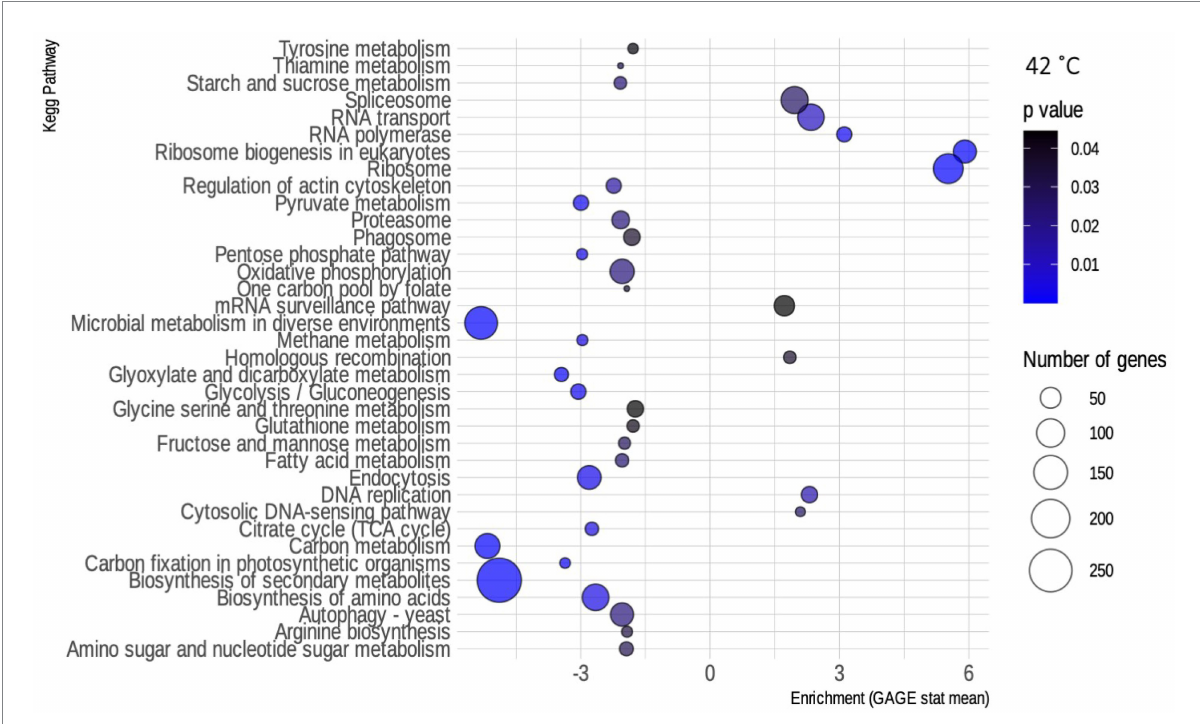
FIGURE 4 Enriched kyoto encyclopedia of genes and genomes (KEGG) pathways for R. toruloides grown at 42 ° C. Bubble map showing the biochemical pathways of R. toruloides noted by KEGG that are enriched in the 42 ° C condition, as obtained by the GAGE package. Pathways that have an enrichment value greater than 0 are up-regulated, while those that have a value less than 0 are down-regulated. Blue scale inside the bubbles represents the decreasing value of ps. The different sizes of the bubbles define the approximate number of DEGs in each biochemical pathway.